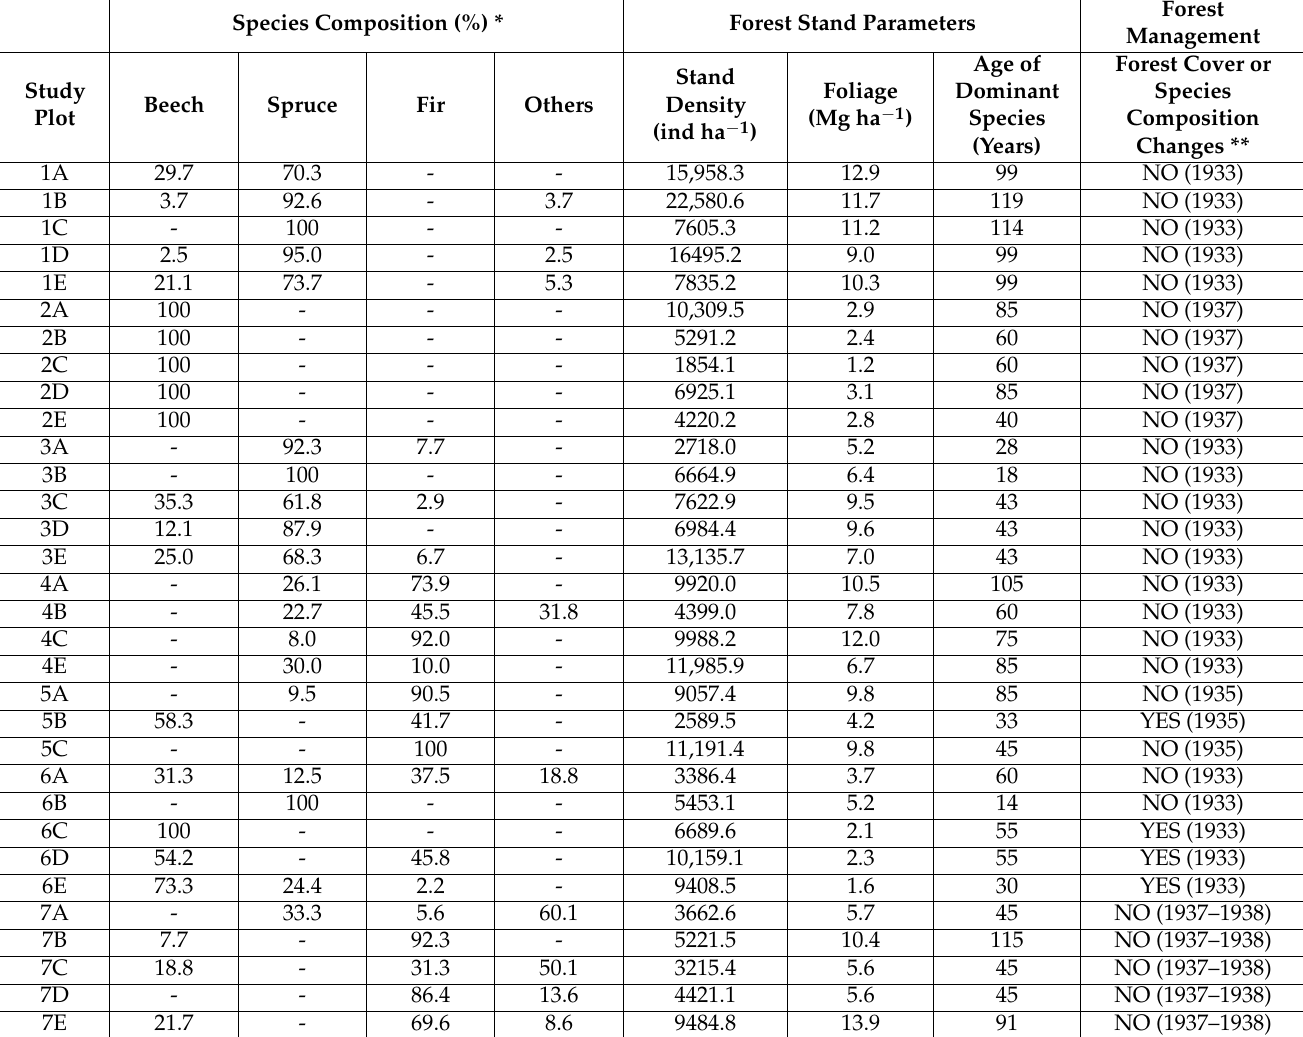
Table 4. Forest stand characteristics at study